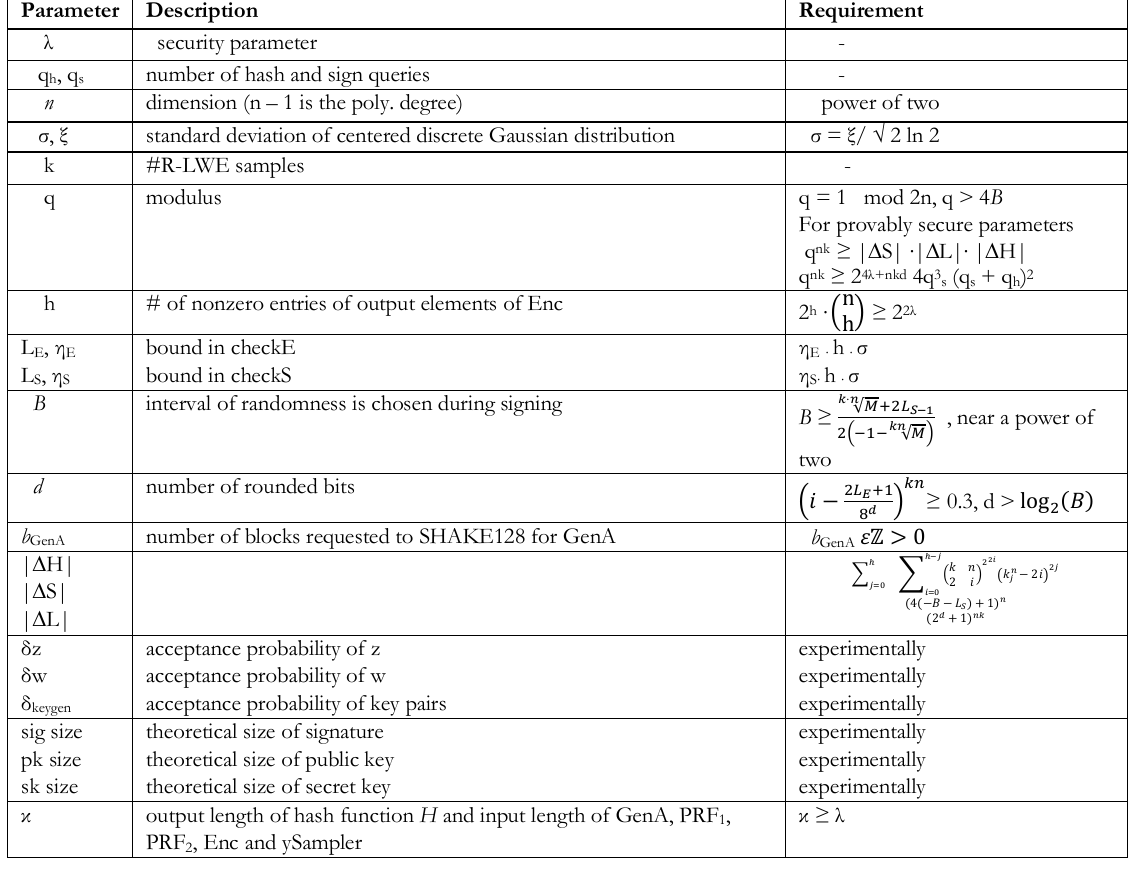
Table 4: Description and bounds of all the system parameters [4]